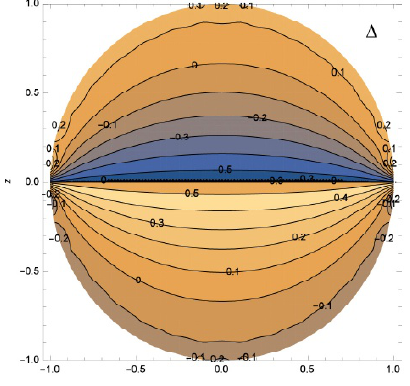
Fig. 8. Strain energies of a JP (curve 1) and a trun- cated dilatation inclusion embedded in an infinite elastic medium (curve 2) as functions of the inter- face coordinate  . The energy values are given in 1 units of 4  (1+  ) G  *2 a 3 /(3(1-  )). The calculations are made for the material with 